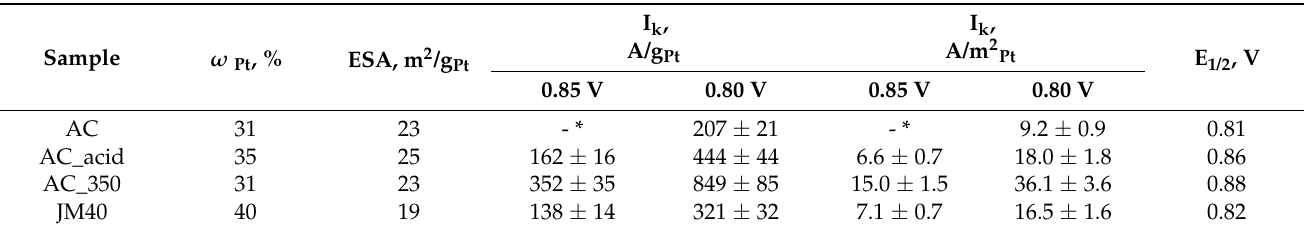
Table 3. The electrochemical characteristics of the PtCu/C catalysts after durability testing.